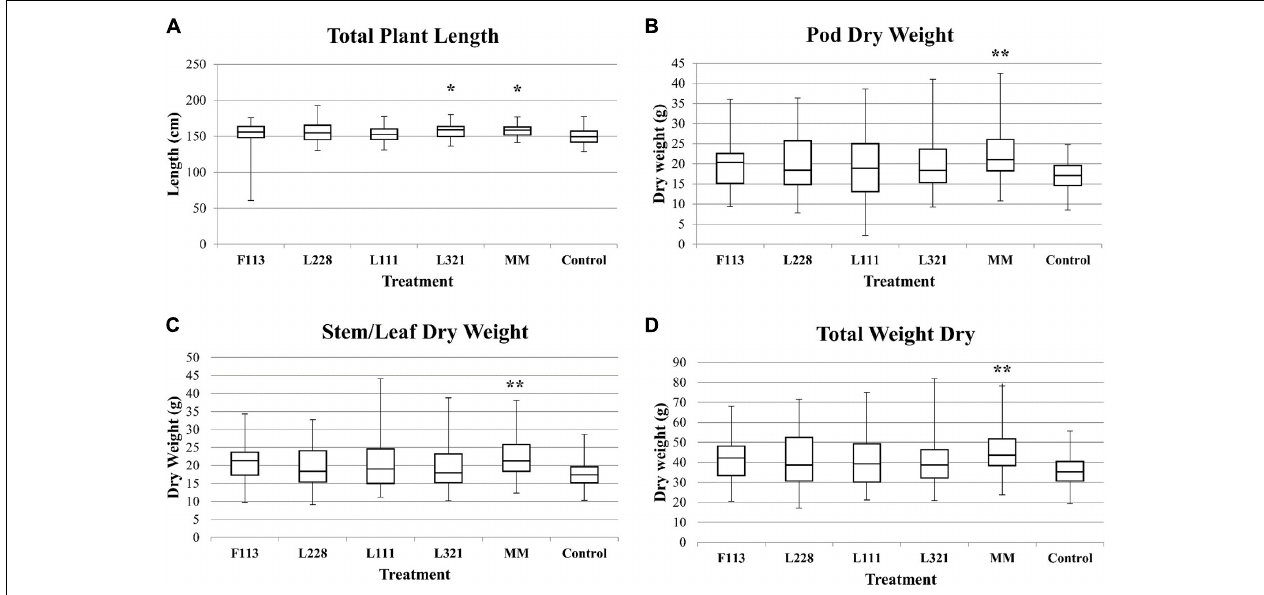
FIGURE 3 | Biomass analysis of B. napus in a field experiment following inoculation by PGP Pseudomonas and a bacterial consortium at 9 months. Box plots provide a summary of the significant field trial data. These graphs represent the variation within the sample populations. (A) The total plant length from the third sample date. (B–D) The DW data from the third sampling date. ∗∗ P < 0.01; ∗ P < 0.05.